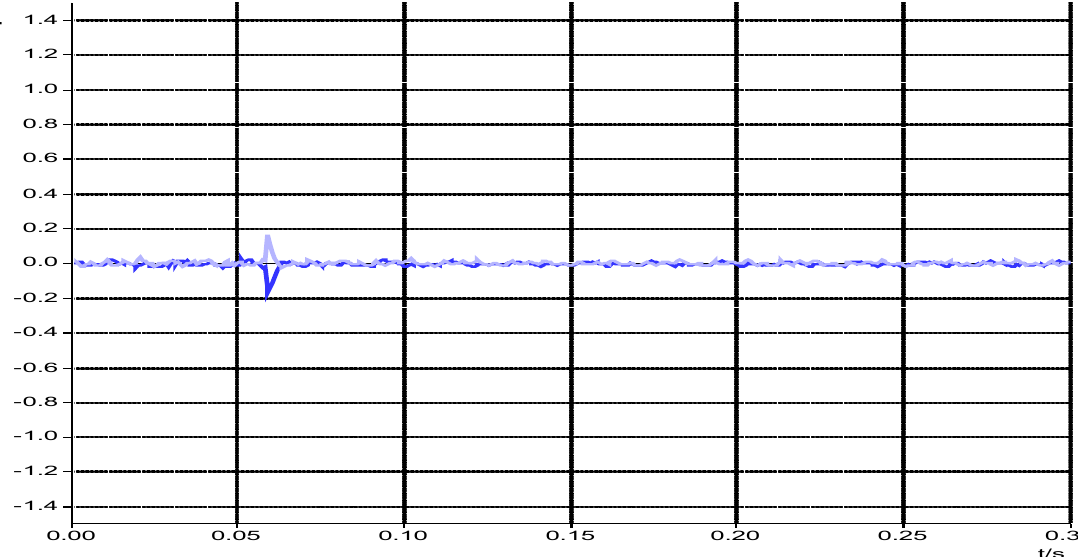
Figure 26. Current for (cid:1856)(cid:1869) axes in a negative sequence. 8. Conclusions The simulation and experimental results in this paper showed that the fault ride through (FRT) capability with SCADA viewer, Active Servo and wind sim software packages are more adaptable to the variations of voltage sag and wind turbines based on a Doubly Fed Induction Generator (DFIG)